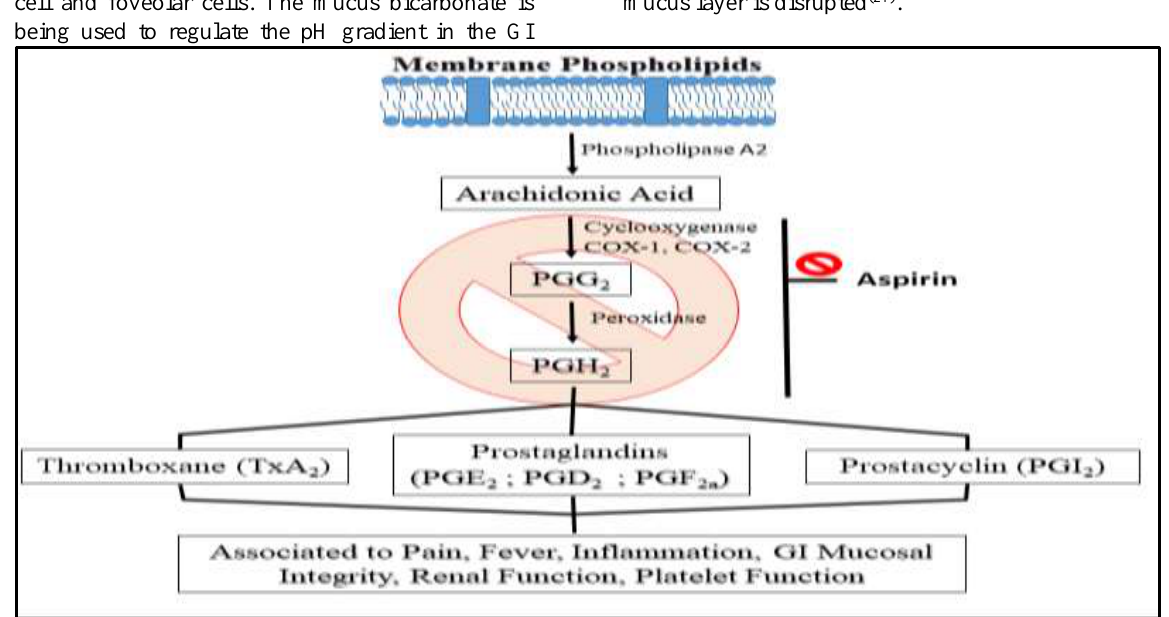
Figure. 2. Mechanism of action of